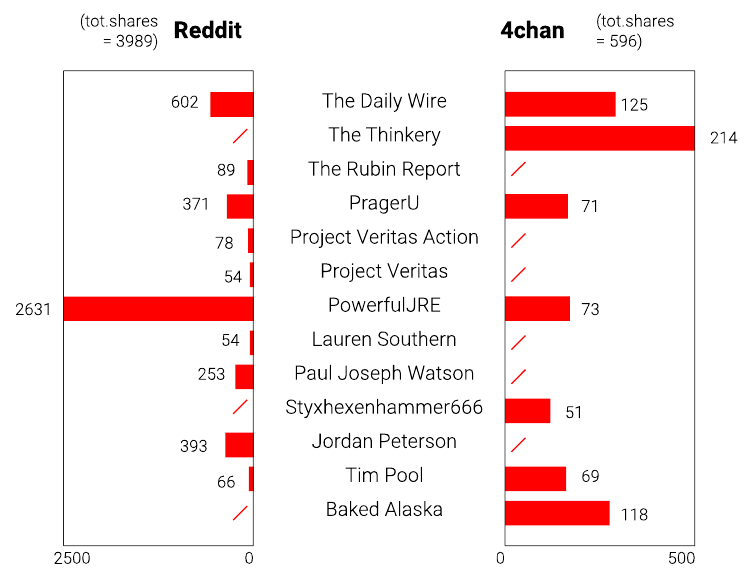
Figure 4. Total shares of each Alternative Influence Network channel on 4chan /pol/ and political Reddit. Retrieved 25 April 2020; data source: